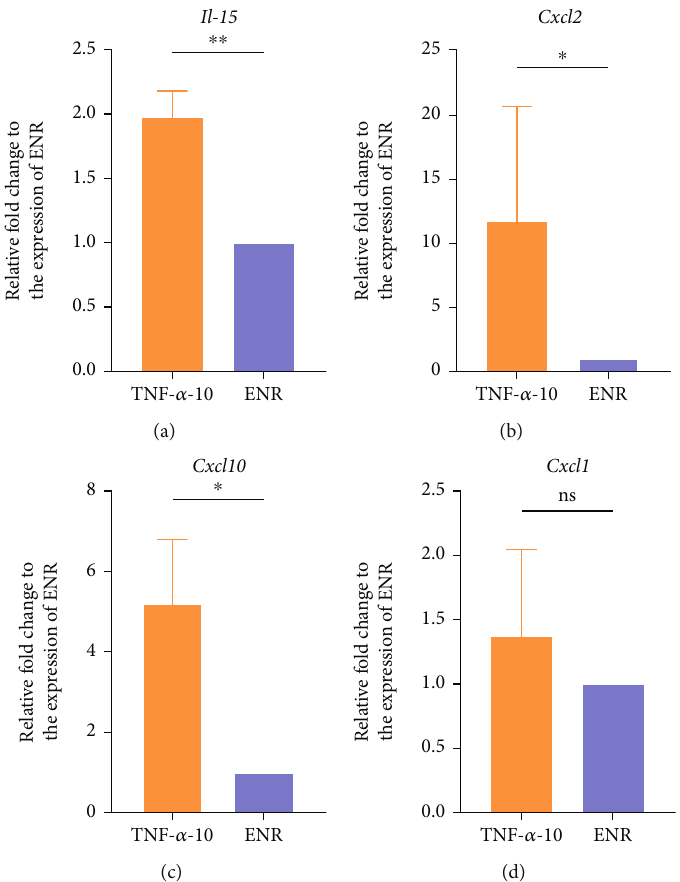
Figure 7: qRT-PCR analyses for in fl ammatory cytokine and chemokine gene expression. qRT-PCR analyses of expression of the cytokine IL-15 (a), chemokines Cxcl2 (b), Cxcl10(c), and Cxcl1 (d) in organoids cultured under the indicated conditions ( n = 1 well). P values were determined by two-sided unpaired Student ’ s t -test. Gapdh was used as a control to normalize the expression of target genes. ∗ P < 0 : 05 ; ∗∗ P < 0 : 01 ; ∗∗∗ P < 0 : 001 . The experiments were independently repeated at least three times with similar